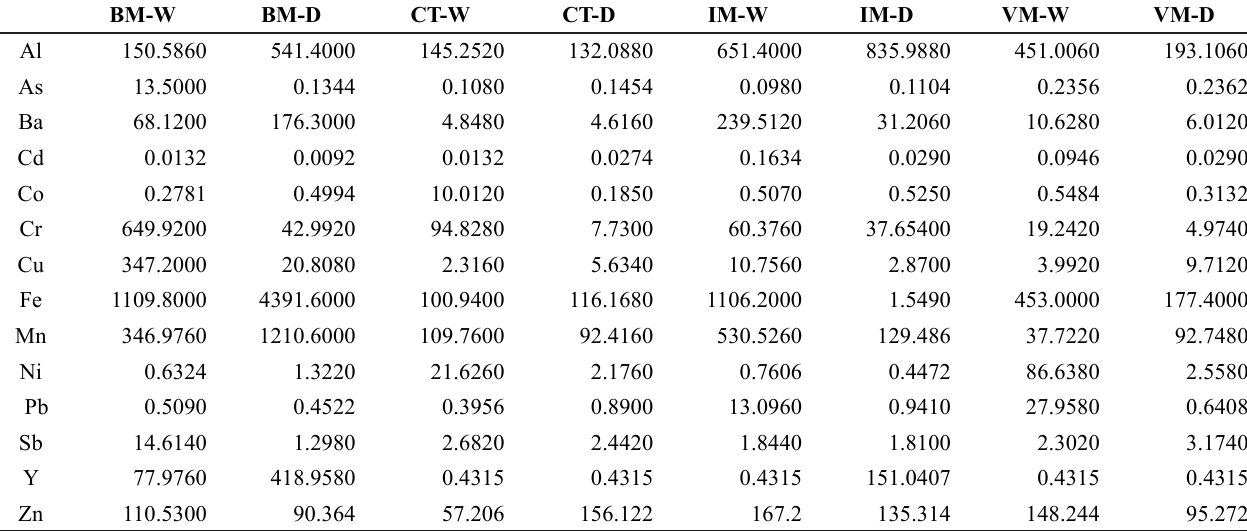
Table 6 . Mineral contents in µg/L for 160 Suspended Particulate Material (SMP) samples collected during wet (W) and dry (D) season, from four sites in the Iron Quadrangle, MG, Brazil (*) average of concentration no samples with <LOQ. Codes for the areas are as in Figure 1.